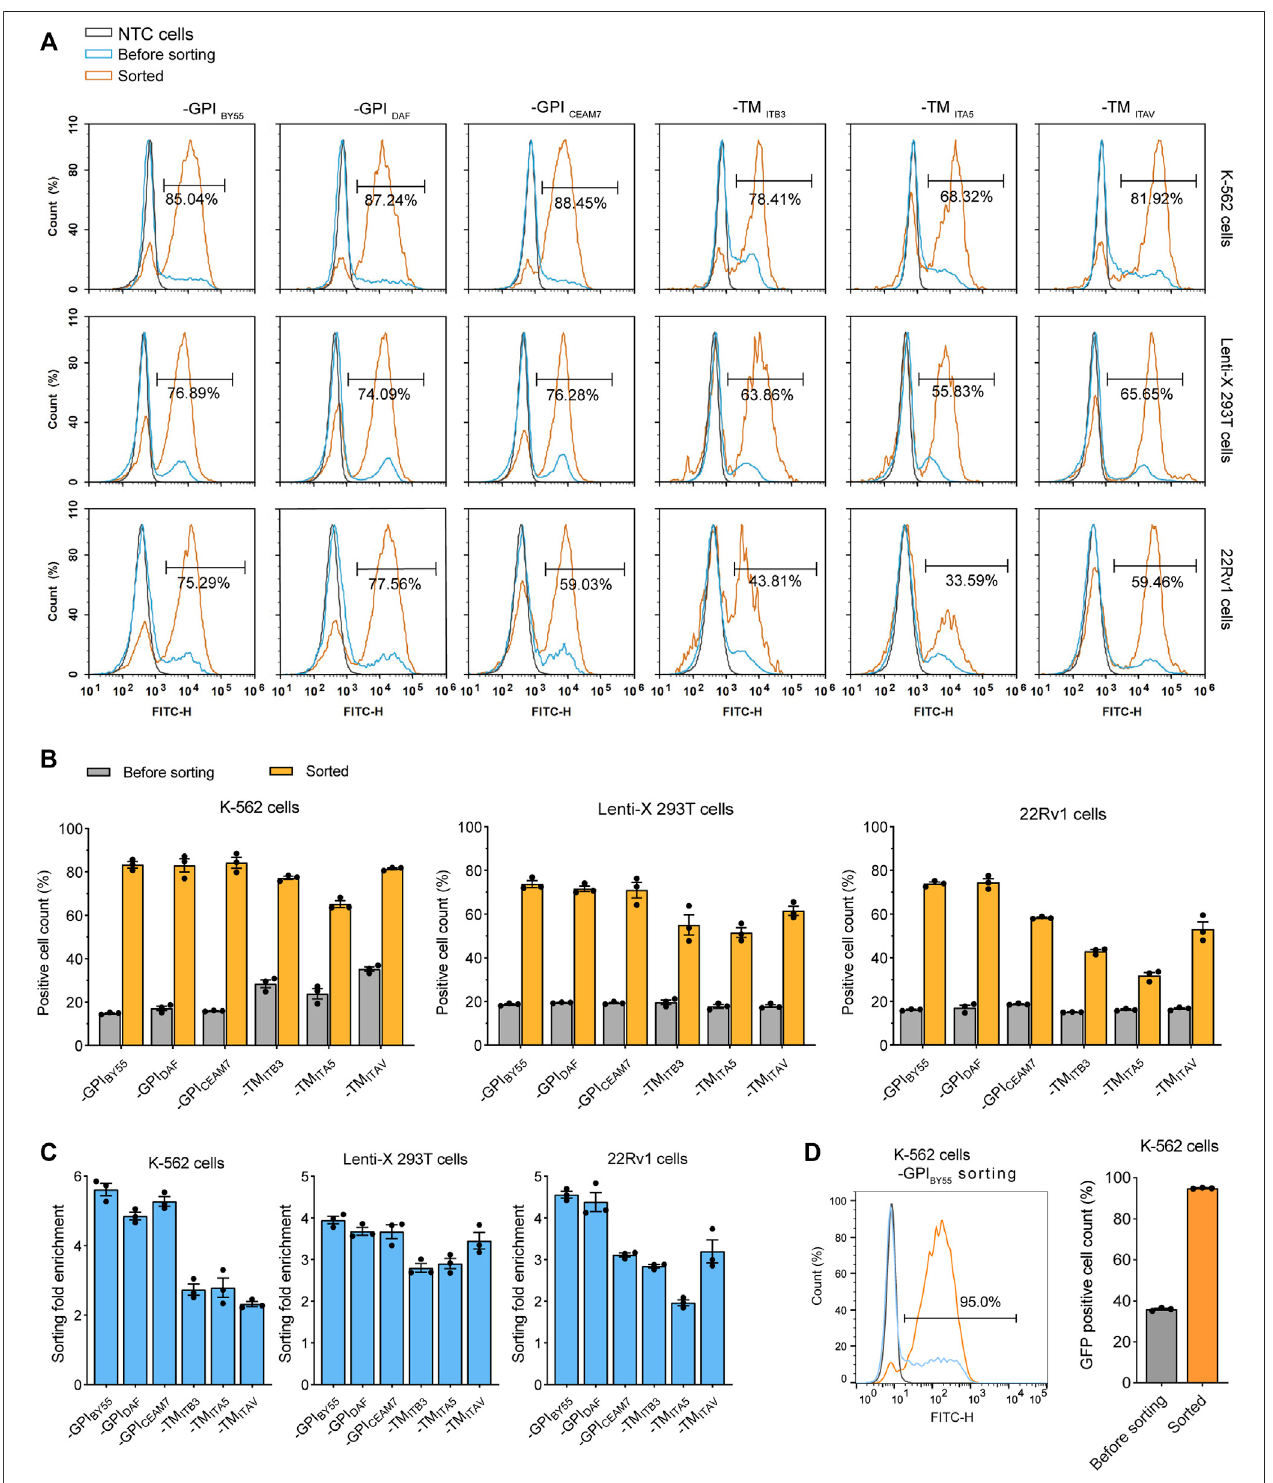
FIGURE 3 | Flow cytometry analysis of cells from af fi nity cell sorting. (A) Flow cytometry histograms of K-562, Lenti-X 293T, and 22Rv1 cells transfected with six sorting tag plasmids, enriched or not by cell sorting. The histogram is presented as the normalized percentage value of the maximum value in the layer histogram. The gray layer represents the negative control cells (NTC) without transfection, and the blue layer represents the transfected cells, the orange layer represents the cells enriched by cell sorting. The percentage of fl uorescence-positive cells in the enriched cells is represented. (B) Bar chart showing the percentage of fl uorescence